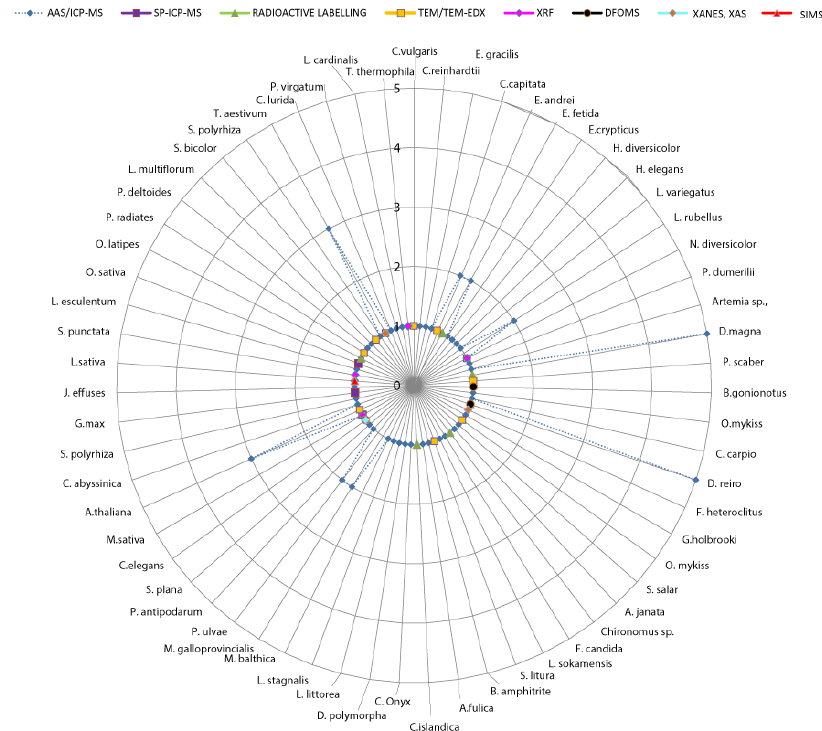
Figure 2. A diagram showing the distribution of Ag NPs studies for 63 different species using the techniques: AAS/ICP-MS, SP-ICP-MS; Radioactive labelling; TEM/TEM-EDX; XRF; DFOMS;